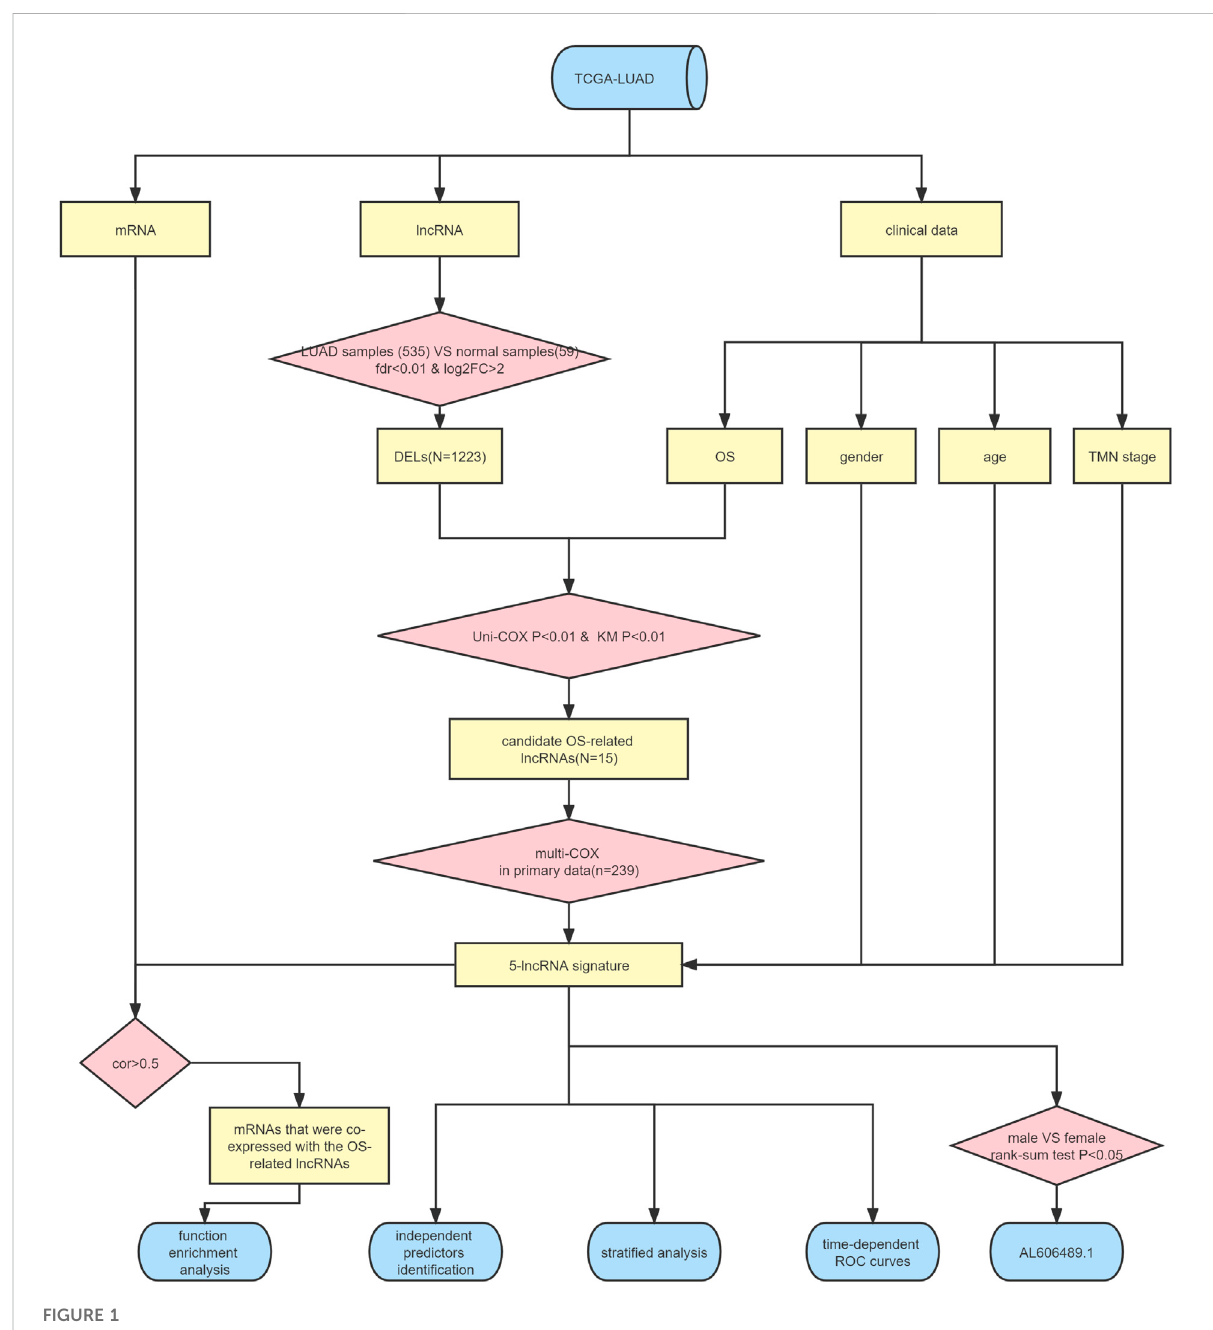
FIGURE 1 Flowchart depicting the study